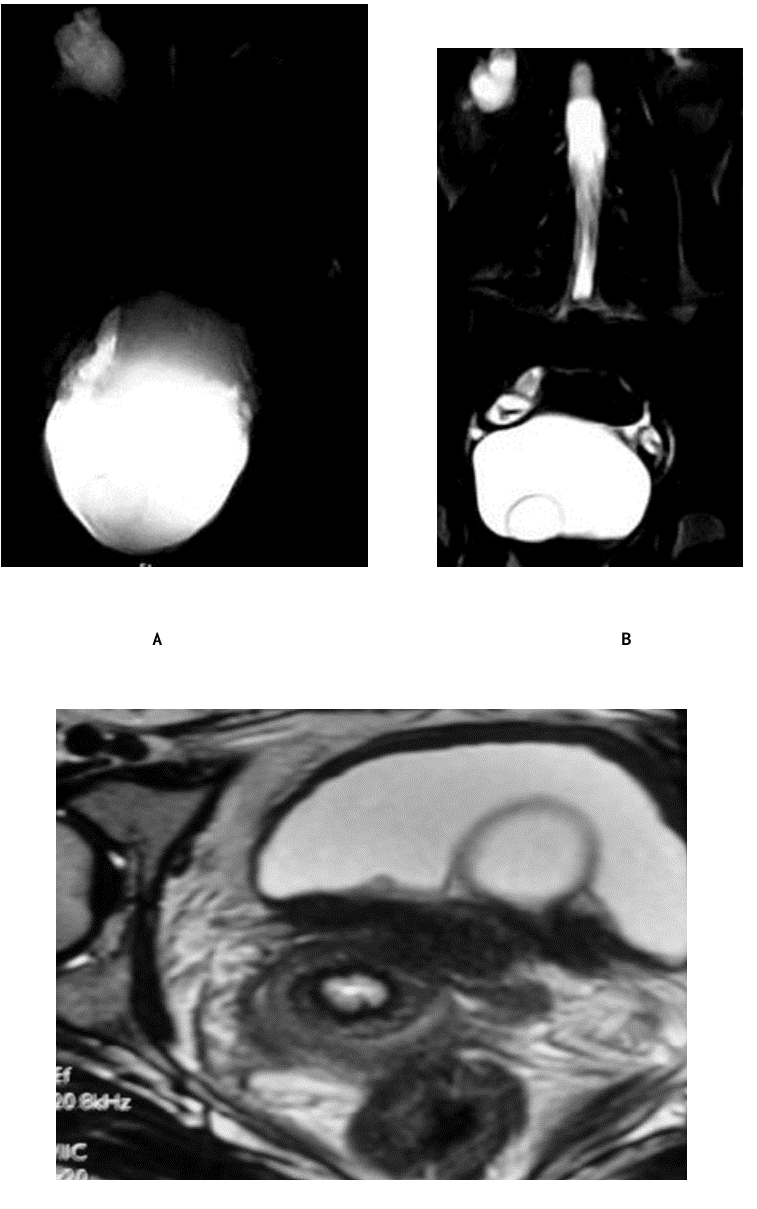
C FIGURE 2. A case of right intravesical ureterocele. (A) Single-shot MRU; the filling defect of the ureterocele could not be identified clearly. (B and C) Coronal source image of MRU and axial T2w at the level of urinary bladder; both show clearly the ureterocele inside the urinary